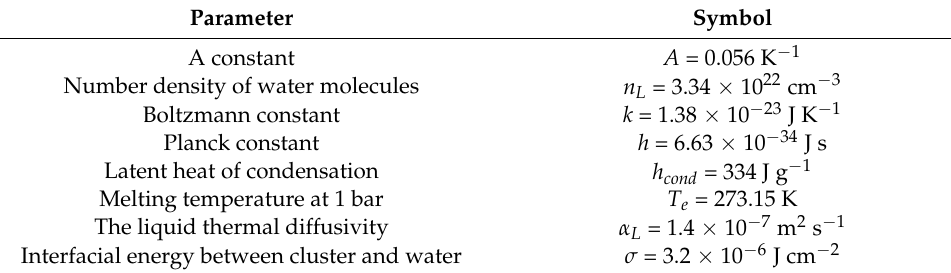
Table 1. Parameters and symbols for ice crystallization